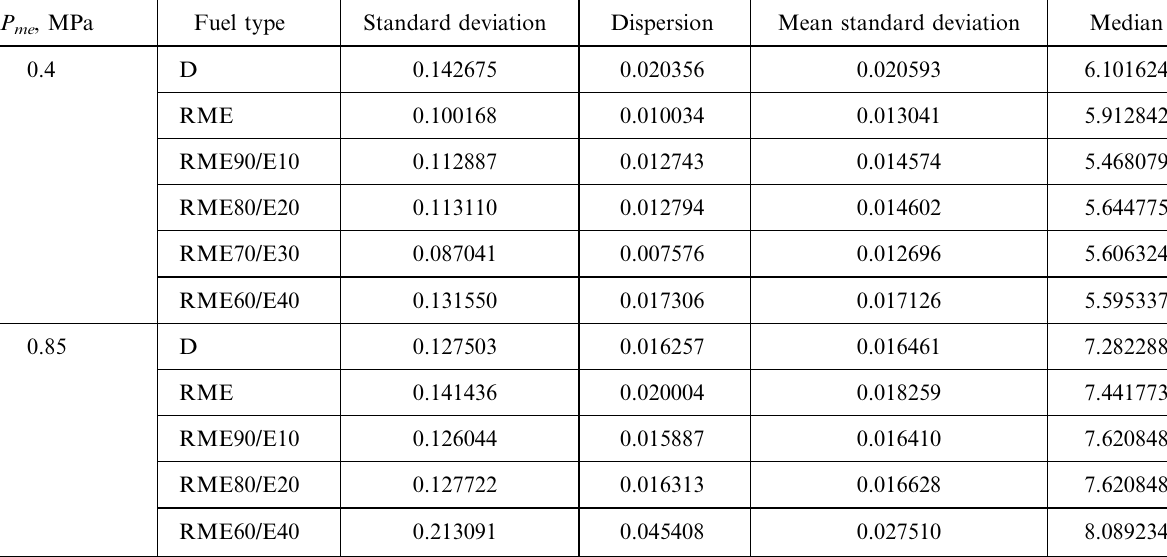
Table 1. Results of statistical evaluation of cyclic instability P me ,